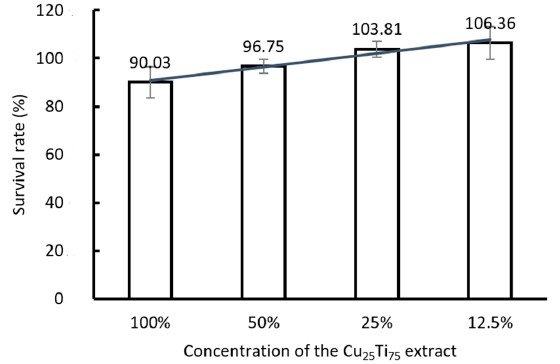
Figure 4. Mitochondrial activity of surviving L929 cells in contact with a 10-day Cu 25 Ti 75 thin film extract (72 h exposure, various extract concentrations, n = 12, MTT (3-[4,5-dimethylthiazol-2-yl]- 2,5-diphenyl bromide) test), the results are presented in relation to the control (100% activity of unexposed cells).